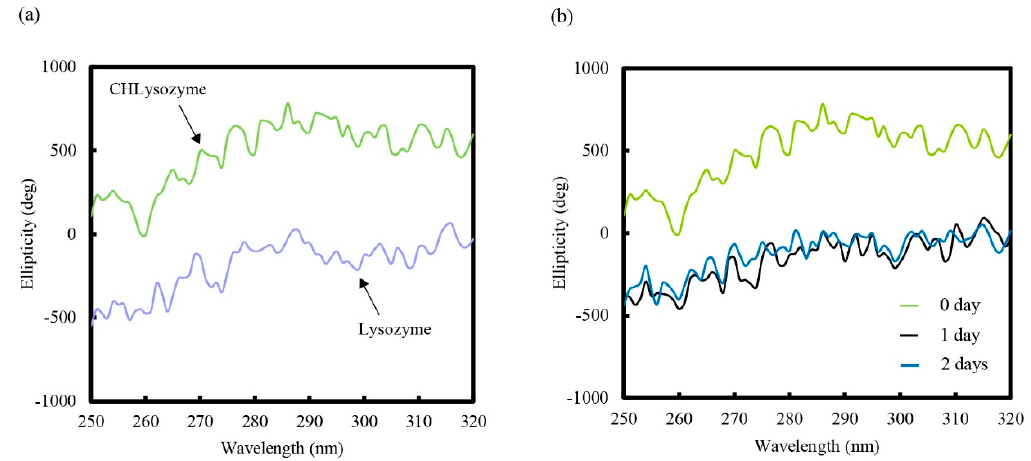
Figure 4. CD spectra of each lysozyme ( a ) and change of CD spectra of CHLysozyme with time ( b ) in the near UV (250 nm to 320 nm) region at 25 °C. Lysozyme and CHLysozyme concentration: 0.2 mg/mL.